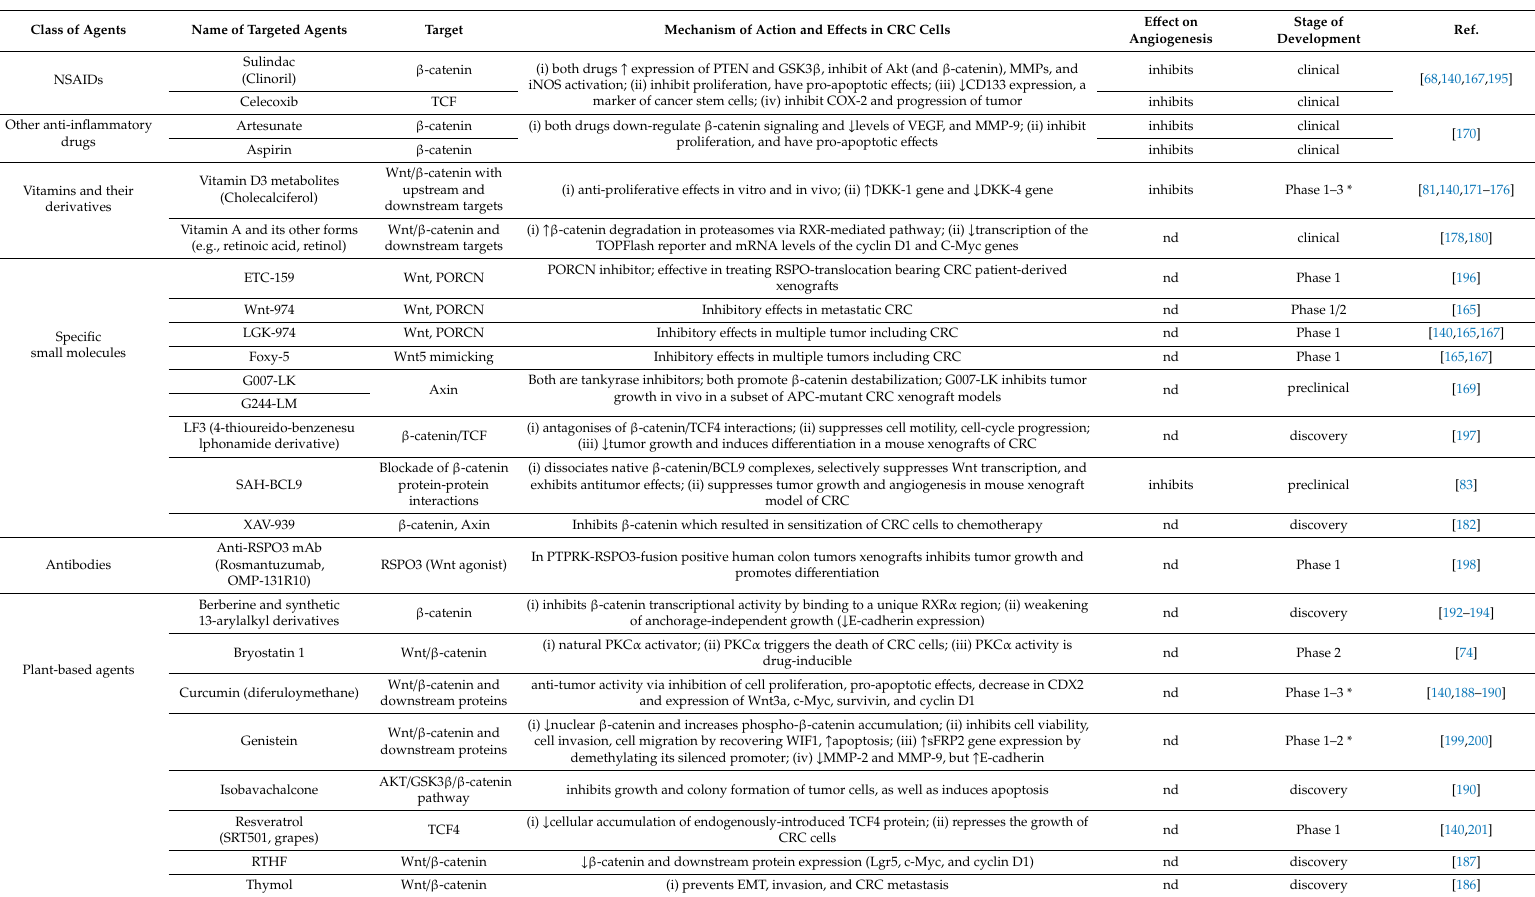
Table 3. Selected classes of existing / potential anti-Wnt / β -catenin signaling therapeutics with anti-angiogenic e ff ects in colorectal cancer